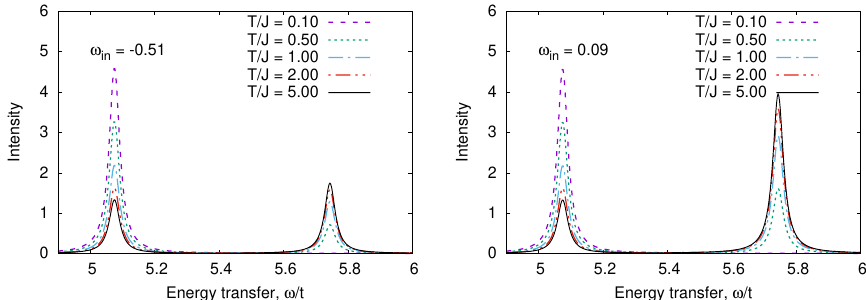
Figure 10. T -dependence of RIXS spectra in a “Cu-O-Cu” molecule for two input frequencies.